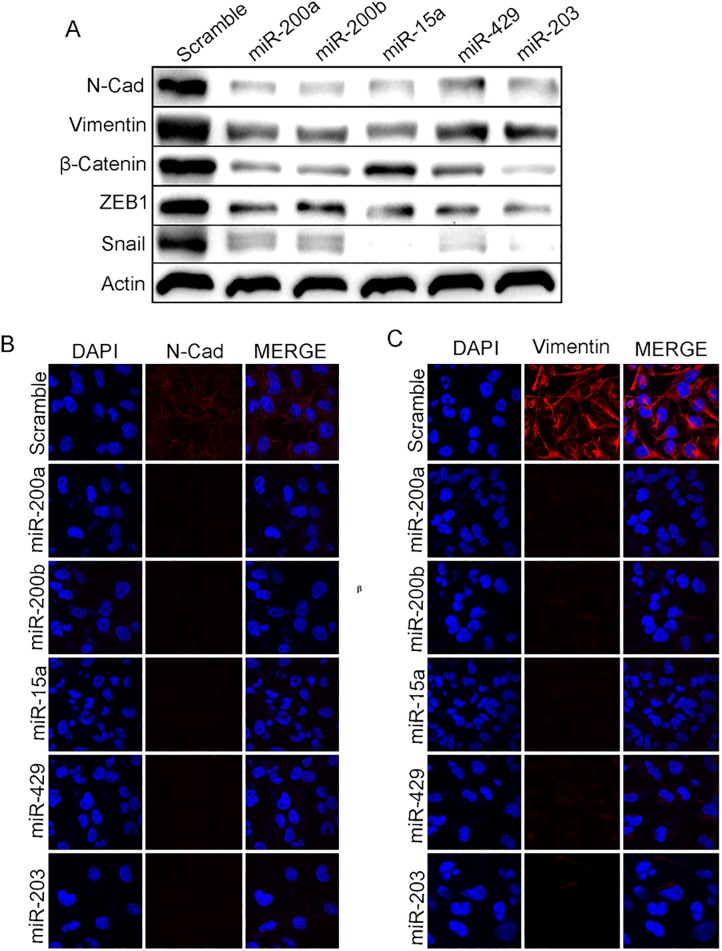
miR-200a, miR-200b, miR-429, and miR-203 induce Mesenchymal to Epithelial transition.Level of expression of N-cadherin, Vimentin, β-Catenin, ZEB-1, Snailin MDAMB-231cells having overexpressed miR-200a, miR-200b, miR-15a, miR-429, and miR-203(A). Cytological localization of Vimentin, N-cadherin in MDAMB-231 cells having mentioned over expressed miRNAs.ScramblemiRNA vector was used as control (B, C).Bar indicates 200μm.